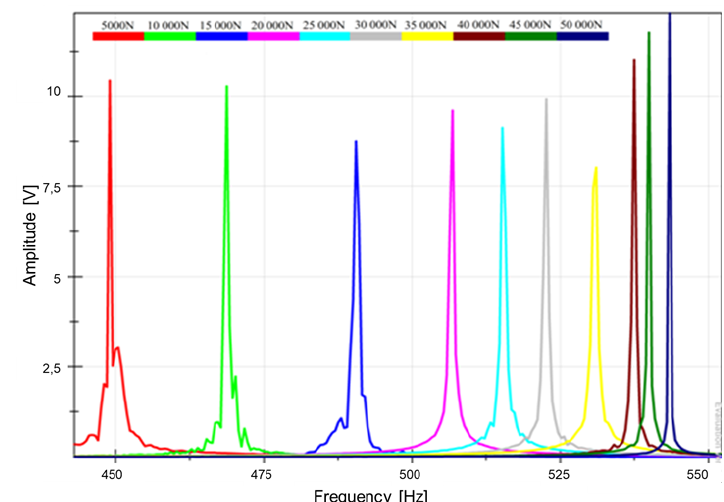
Figure 5. The shift in the resonance frequency for a steel beam related to the change of